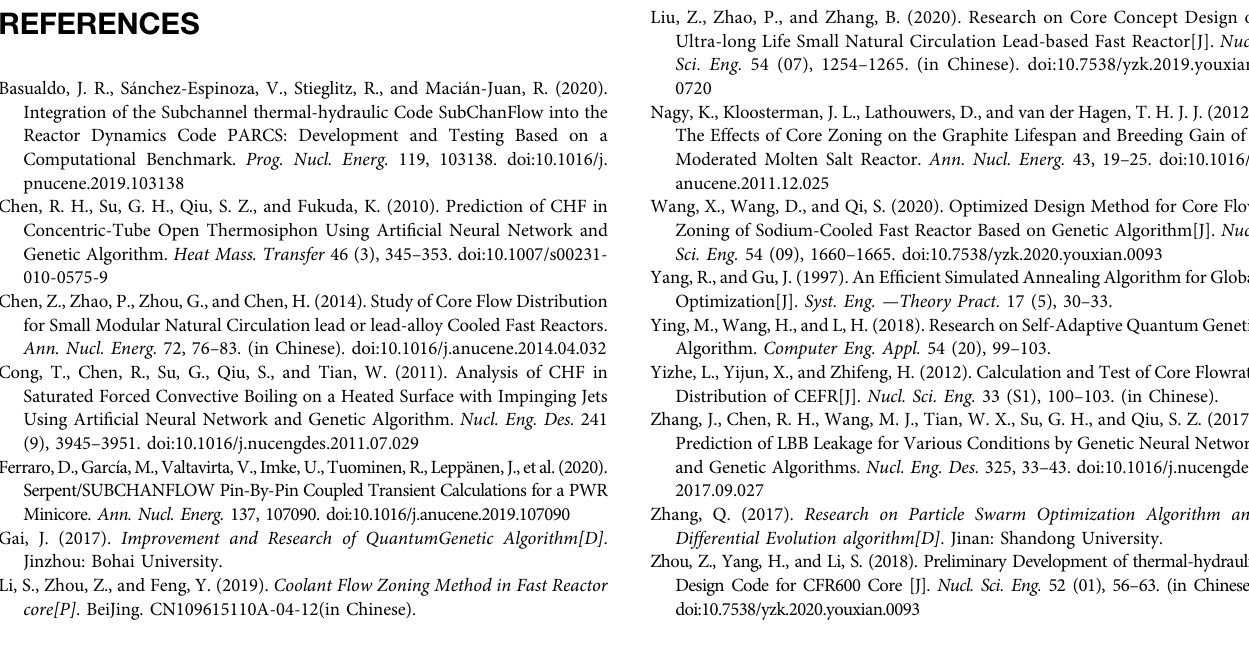
algorithm, differential evolution algorithm, and